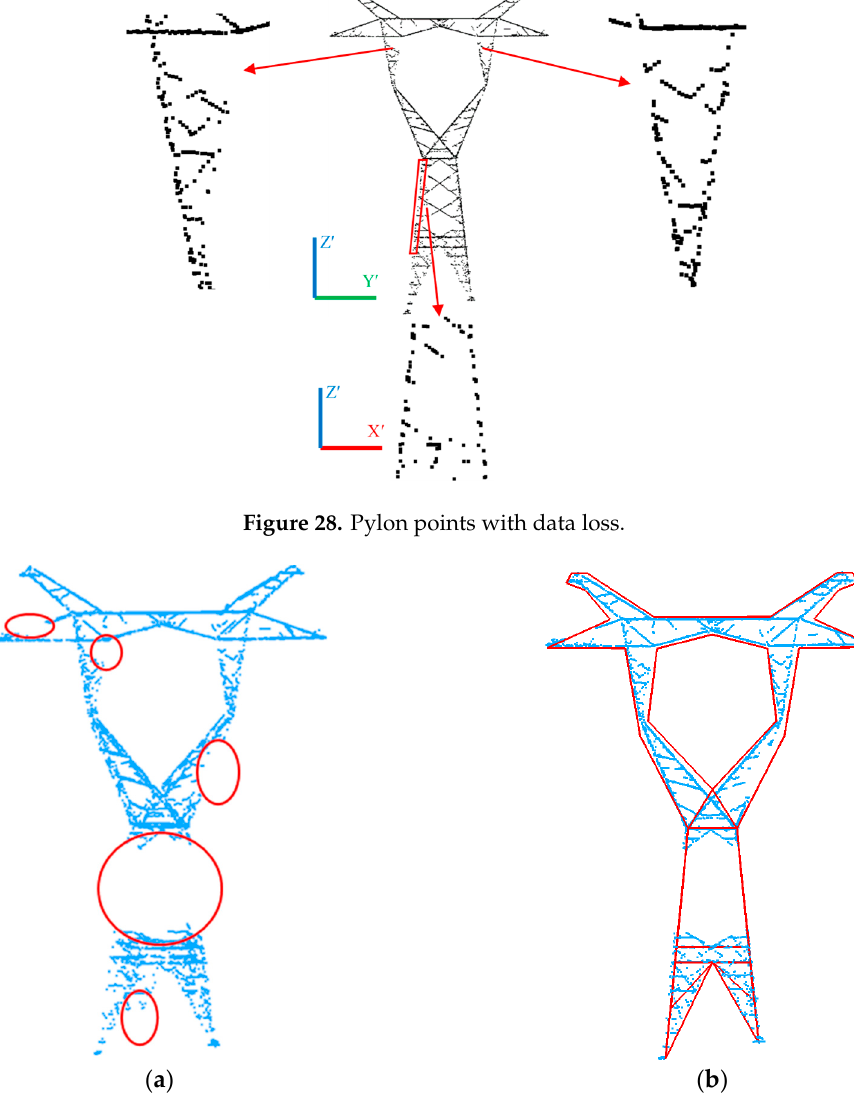
Figure 29. The pylon with data loss and 3D pylon model: ( a ) Pylon with data loss; ( b ) the result of pylon reconstruction with data loss.